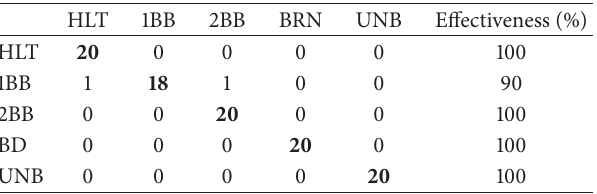
Table 3: Effectiveness percentage of the proposed methodology (confusion